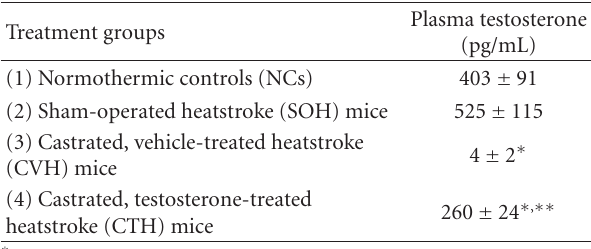
Figure 2: The rectal temperature changes 1–4 hours post-whole body heating (WBH) for normothermic controls (NC), castrated, vehicle-treated heatstroke (CVH) mice, castrated, testosterone- treated heatstroke (CTH) mice, and sham-operated, heatstroke (SOH) mice. Data are means ± SEM ( n = 6 ∼ 9). ∗ P < . 05 compared with NC group. ∗∗ P < . 05 compared with SOH group. ∗∗∗ P < . 05 compared with CVH group. Table 1: Plasma levels of testosterone for di ff erent groups of